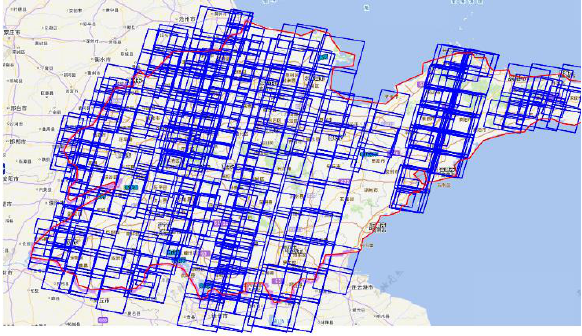
Figure 1. Satellite image coverage diagram